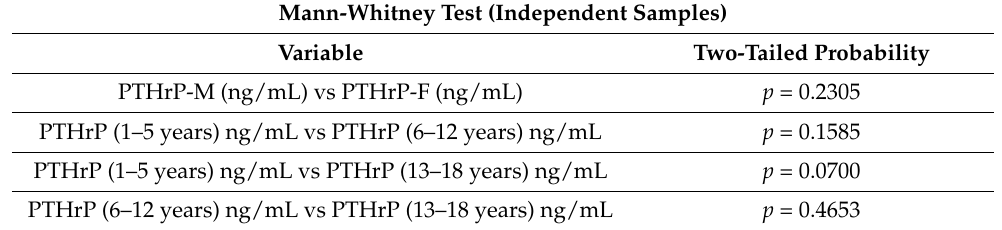
Figure 5. Plot of the scatter diagram of the measurements versus the three groups of subjects evaluated: (1) 1–5 years, (2) 6–12 years and (3) 13–18 years. evaluated: (1) 1–5 years, (2) 6–12 years and (3) 13–18 years. Table 4. Comparison of the difference between means in the groups of subjects stratified by sex and age (Mann-Whitney